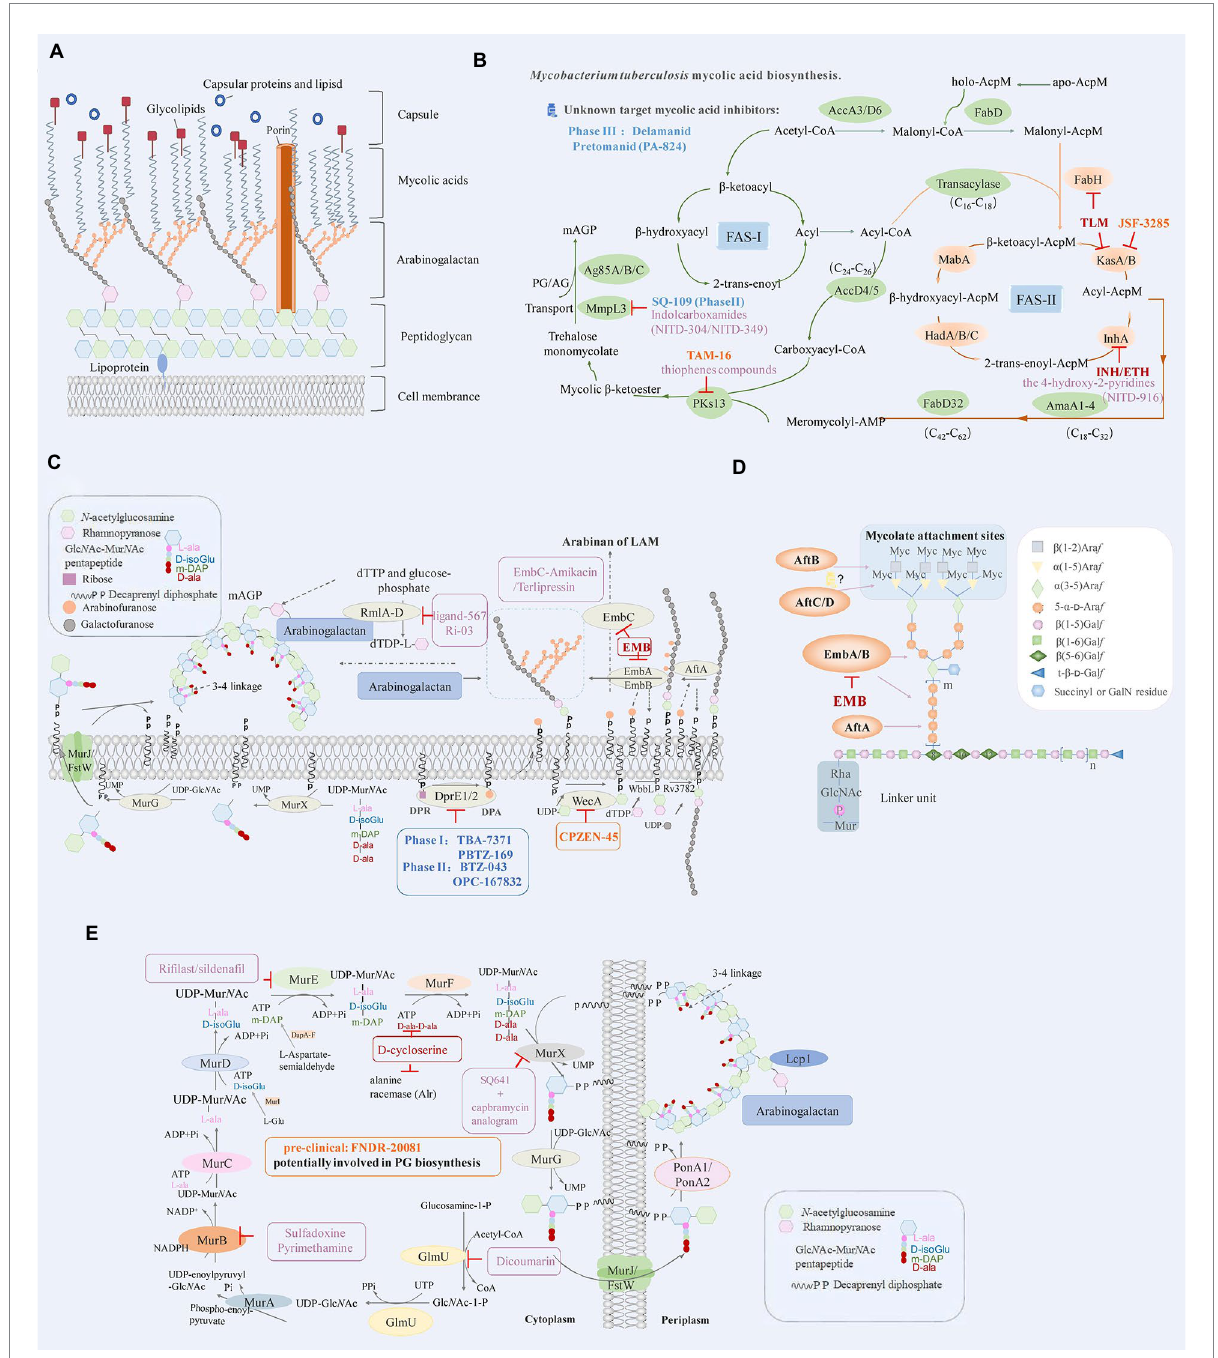
FIGURE 1 (A) Schematic representation of Mycobacterium tuberculosis cell envelope. (B) Mycobacterium tuberculosis mycolic acid biosynthesis. The key enzymes and drug targets of mycolic acids biosynthesis are shown as indicated. FAS-I: fatty acid synthase types I, FAS-II: fatty acid synthase types I. (C) Drugs targeting the decaprenylphosphoryl arabinose biosynthesis pathway. DPA, the precursor of arabinan, is synthesized by the epimerization of DPR by DprE1 and DprE2. The key enzymes and drug targets of decaprenylphosphoryl arabinose biosynthesis are shown as indicated. (D) Structure of mycobacterial arabinogalactan and roles of key enzymes that are responsible for its biosynthesis. (E) The biosynthesis pathway of peptidoglycan in M . tuberculosis and roles of key enzymes that are responsible for its biosynthesis. The key enzymes and drug targets of peptidoglycan biosynthesis are shown as indicated. The diagram represents the drugs (red) that are effective against M . tuberculosis , drugs in clinical trials (blue), pre-clinical (orange), and compounds in the discovery stage with promising development